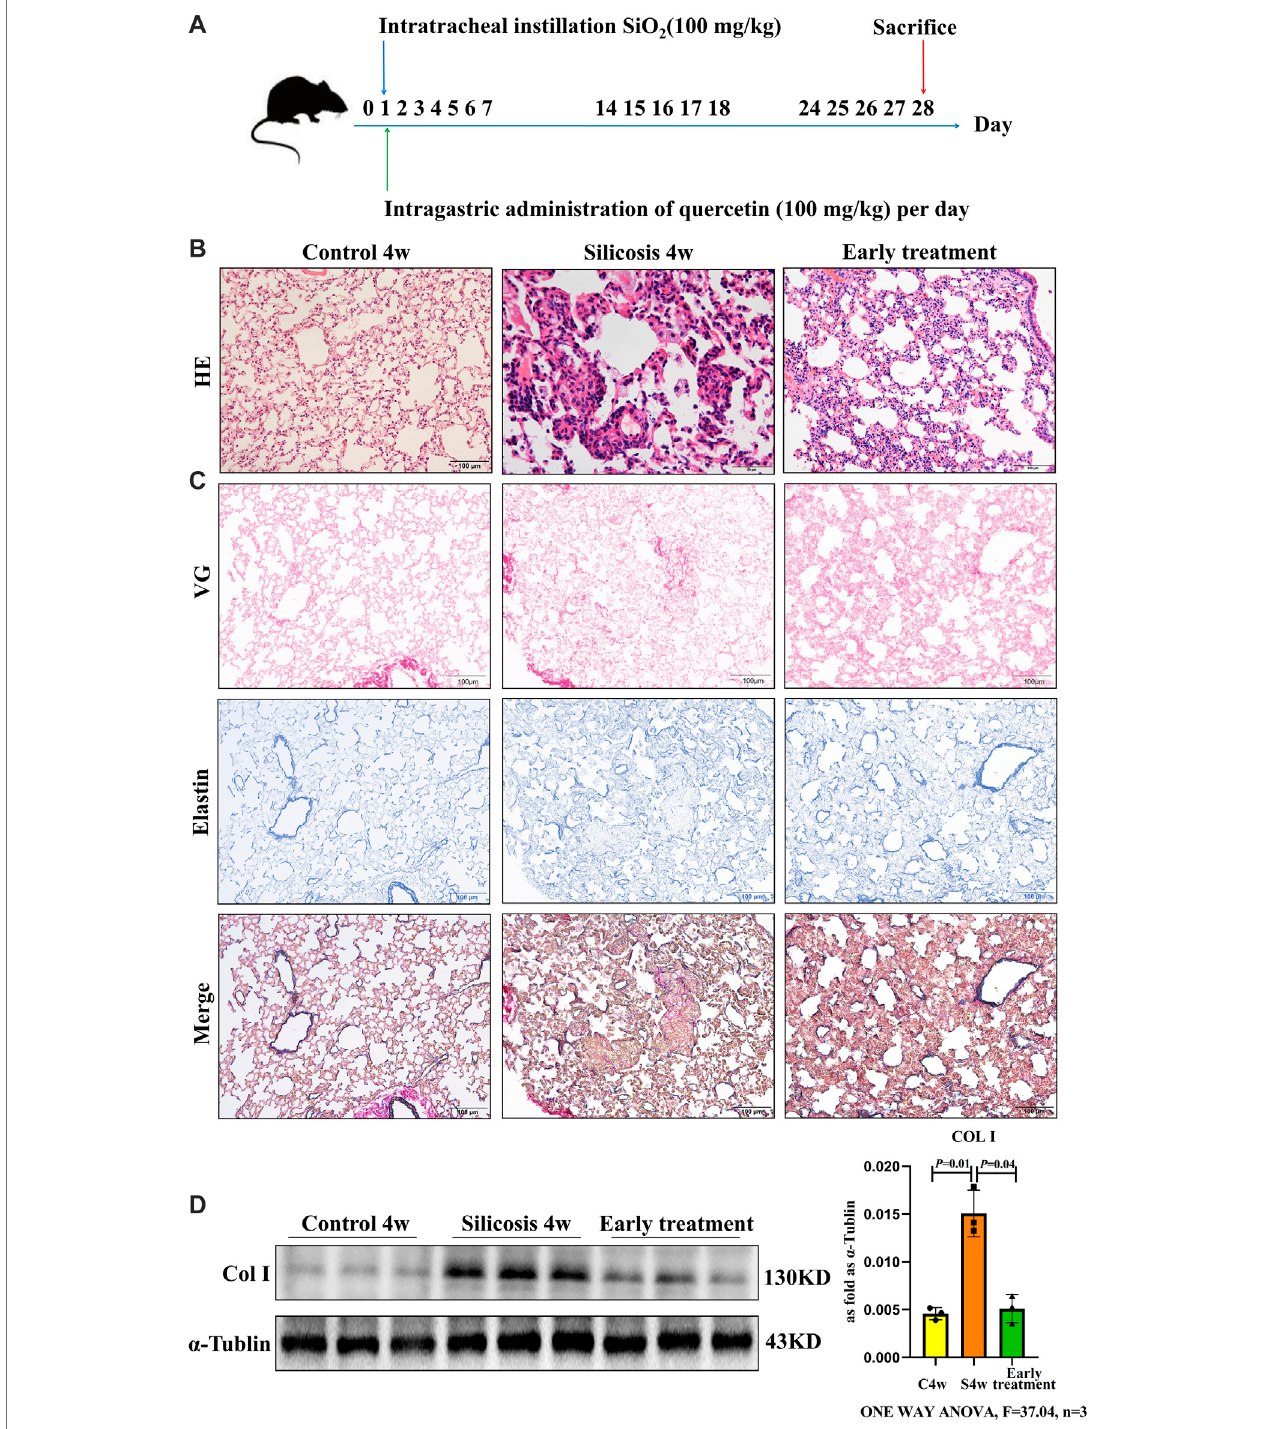
FIGURE1| Quercetinattenuateslunginjuryinanearlytherapeuticsilicosismodel. (A) Schematicofquercetin administration inanearlytherapeuticsilicosismodel. (B) Representative micrographs showing lung injury by HE staining. (C) VG and elastin staining of lung tissue sections. (D) Col I expression by western blot. Data are presented as the mean ± SD. n = 3 per